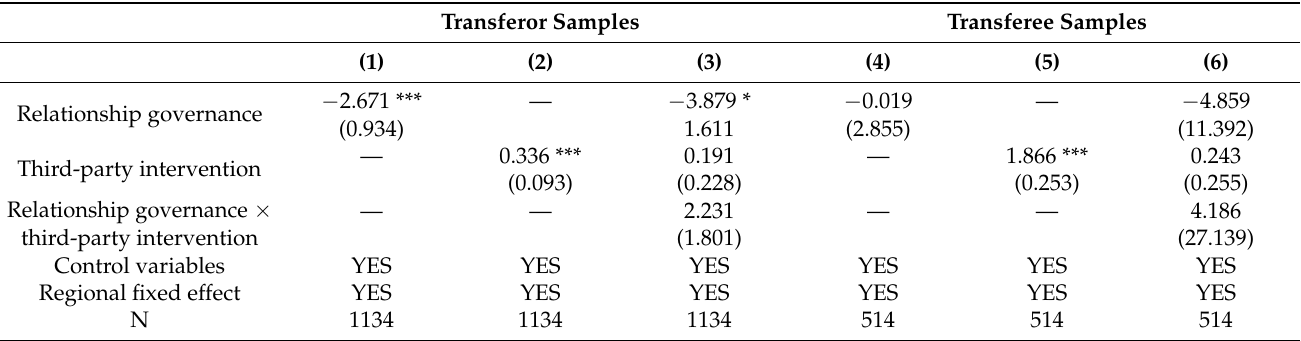
Table 7. Relationship governance, third-party intervention and transfer rent. Transferor